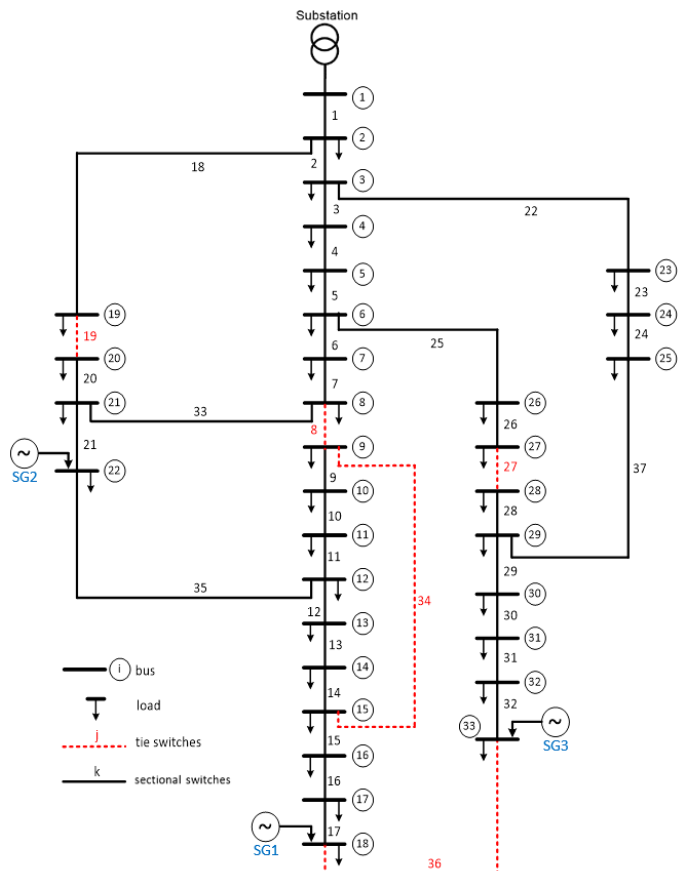
Figure 6. The final configuration of the IEEE model distribution network 33-bus with three